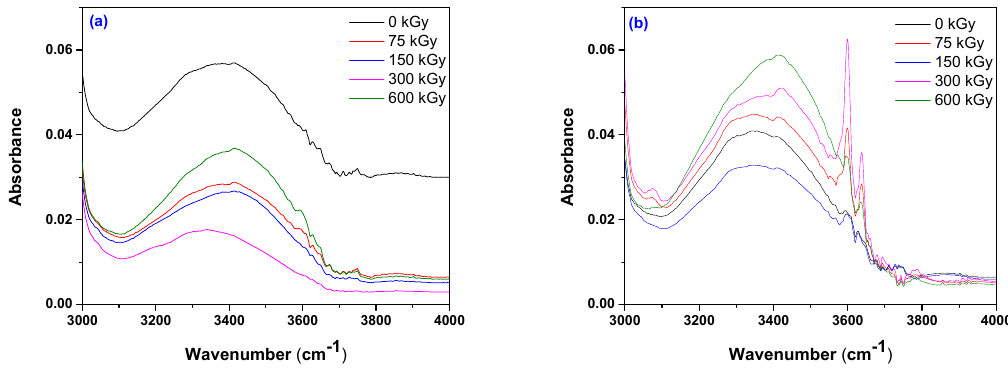
Figure 10. FTIR spectra of EPDM-EB-S 5 ( a ) and EPDM-EB-S 15 ( b ) composites cross-linked by EB irradiation.